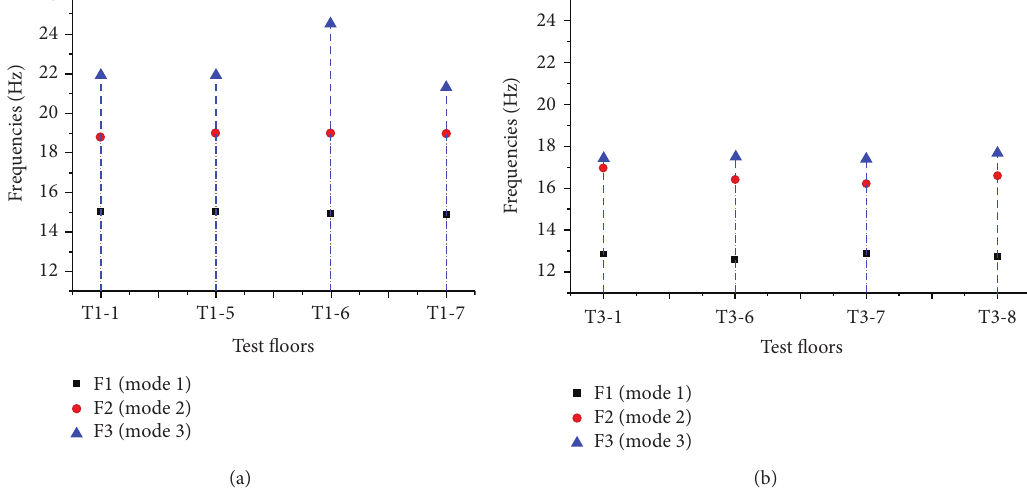
Figure 9: The first three natural frequencies of the test floors with the joist spacings of 400mm and 600mm before and after the installation of strappings.